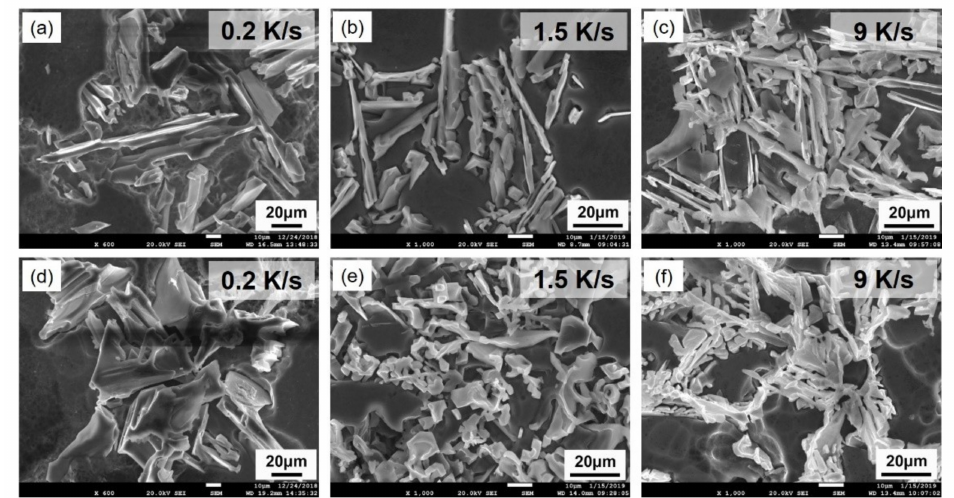
Figure 6. The 3D morphology of eutectic Si in ( a – c ) Al7SiMg and ( d – f ) Al7SiMg + 0.4La alloys at di ff erent cooling